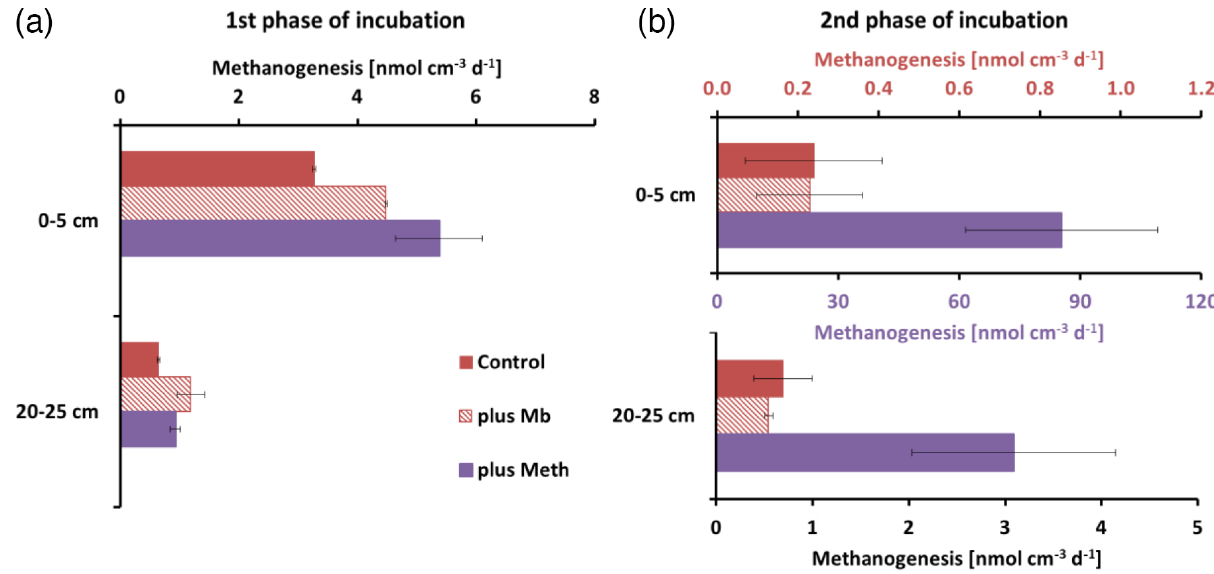
Figure 4. Potential methanogenesis rates in sediment slurry experiments from the two sediment intervals (0–5 and 20–25cm) at St. 1 (70m). The first phase of the incubation shows rates calculated from day 0–5 (a) , while the second phase of the incubation summarizes the rates from day 8–23 (b) . “Control” is the treatment with sulfate-rich (28mM) artificial seawater medium, “plus Mb” is the treatment with sulfate-rich artificial seawater medium plus molybdate (Mb, 22mM), and “plus Meth” is defined as the treatment with sulfate-rich artificial seawater medium plus methanol (Meth, 10mM). Per treatment, average values are shown with standard deviation. Please note the split-up in the diagram in (b) and the different x axis for